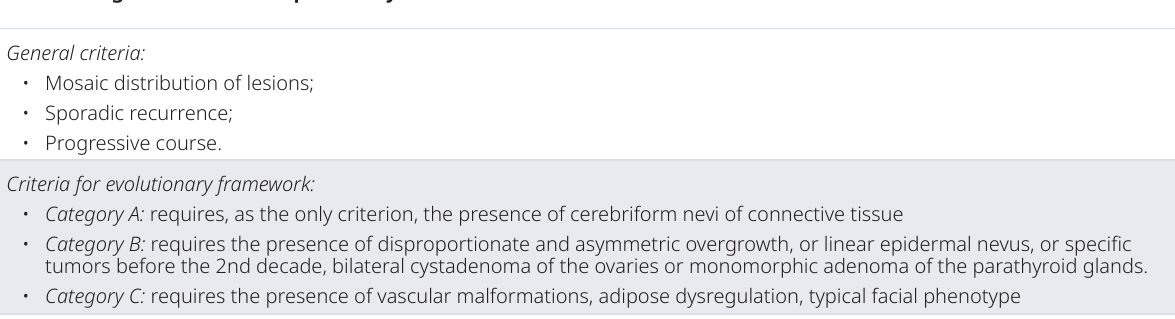
(Table 1): all three general criteria plus a criterion relating to category A; two criteria of category B; three criteria of